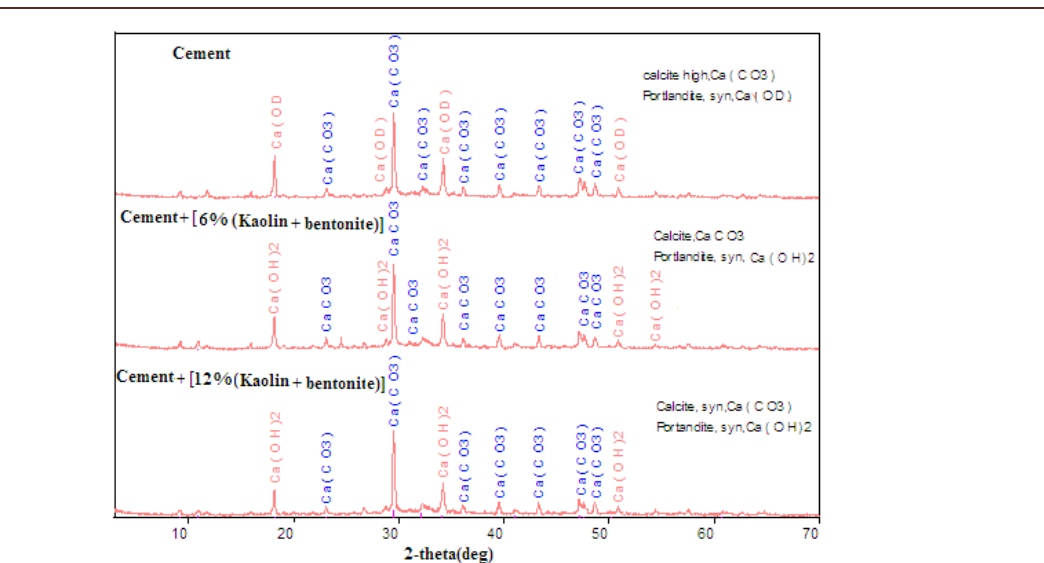
Figure 4: XRD pattern of cement, and cement-kaolin-bentonite mixture, the kaolin-bentonite was submitted to 800 ºC heat for 1 hour.